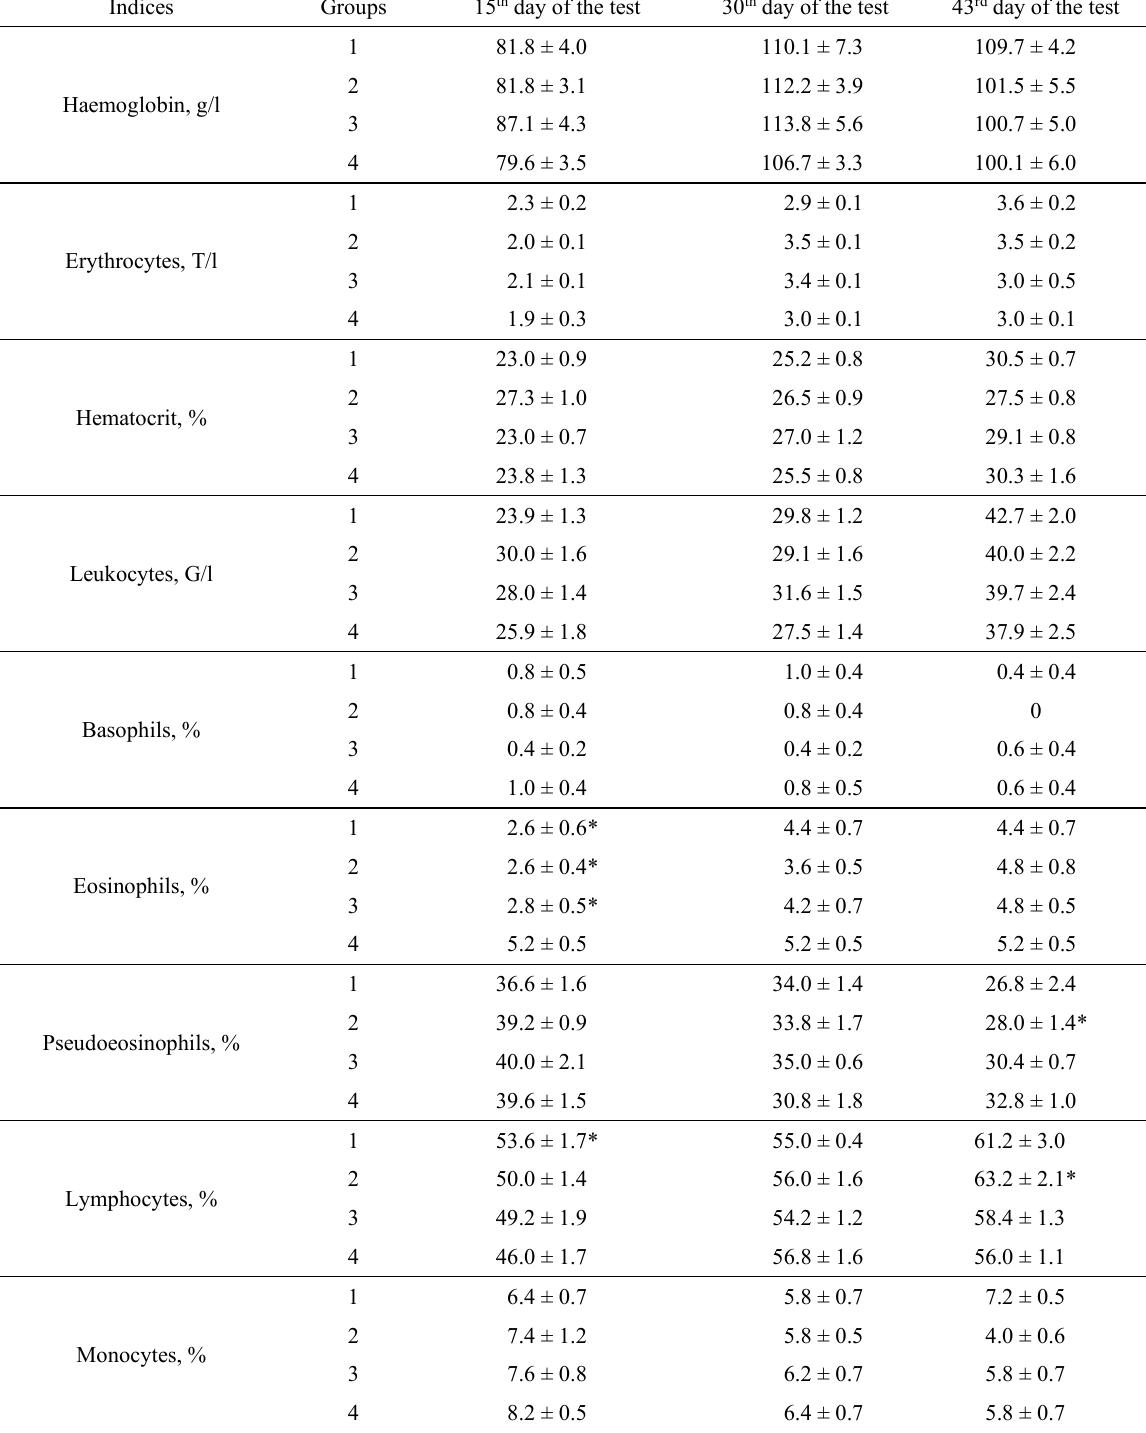
Morphological indices of broiler chicken’s blood at the application of probiotic feed additives (М ± m, n = 10) Indices Groups 15 th day of the test